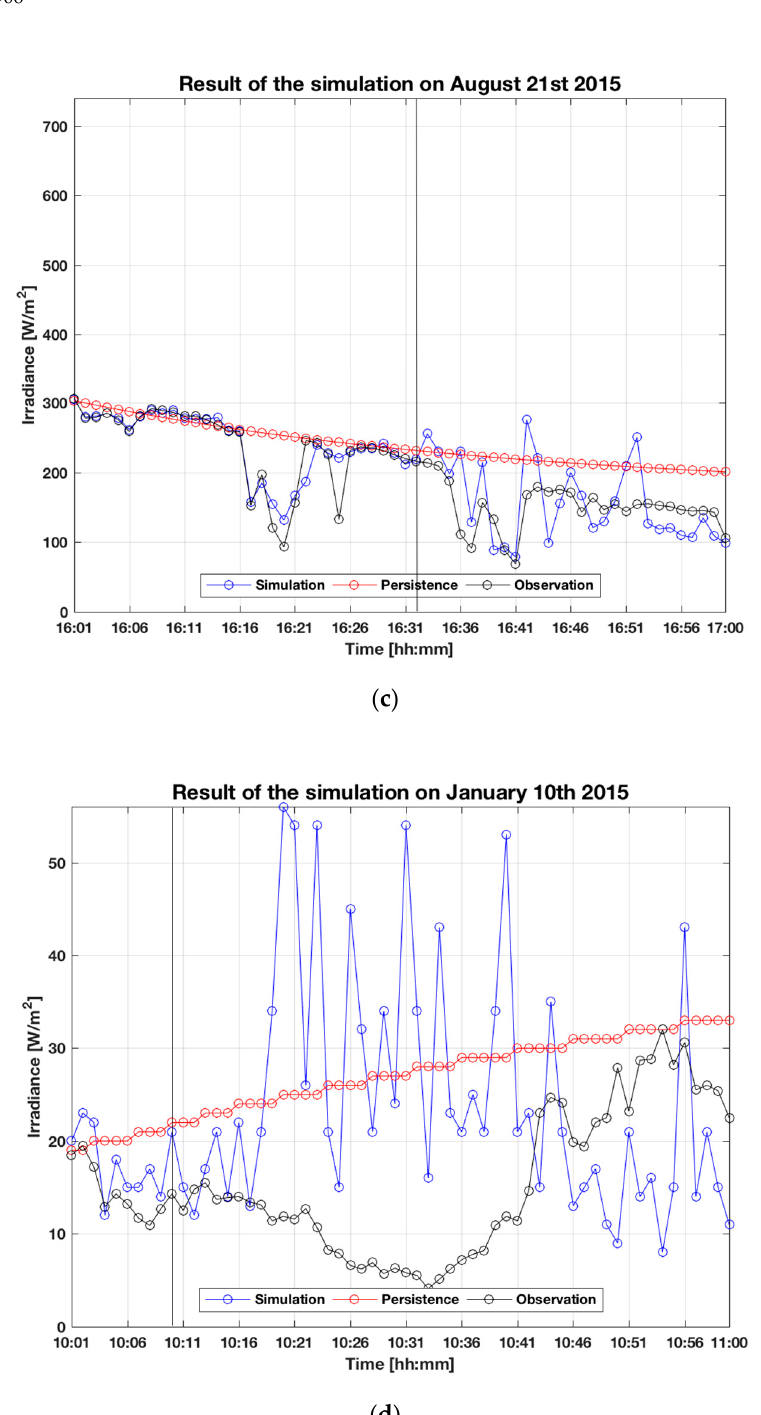
Figure 4. Comparison of new ANN model and persistence model for one-hour-ahead simulation. The vertical black lines in the graphs represent the border of minutes of future information from the last taken picture. ( a ) shows a good prediction of the total amount of energy with R 2 = 0.92. ( b ) shows a good prediction especially for the first minutes of simulation. ( c ) shows a good prediction for the first 32 min of simulation. ( d ) shows a very important deviation with respect to the measured data; R 2 = 38. However, irradiance values of under 80 W/m 2 are of minor importance for the overall energy forecast.